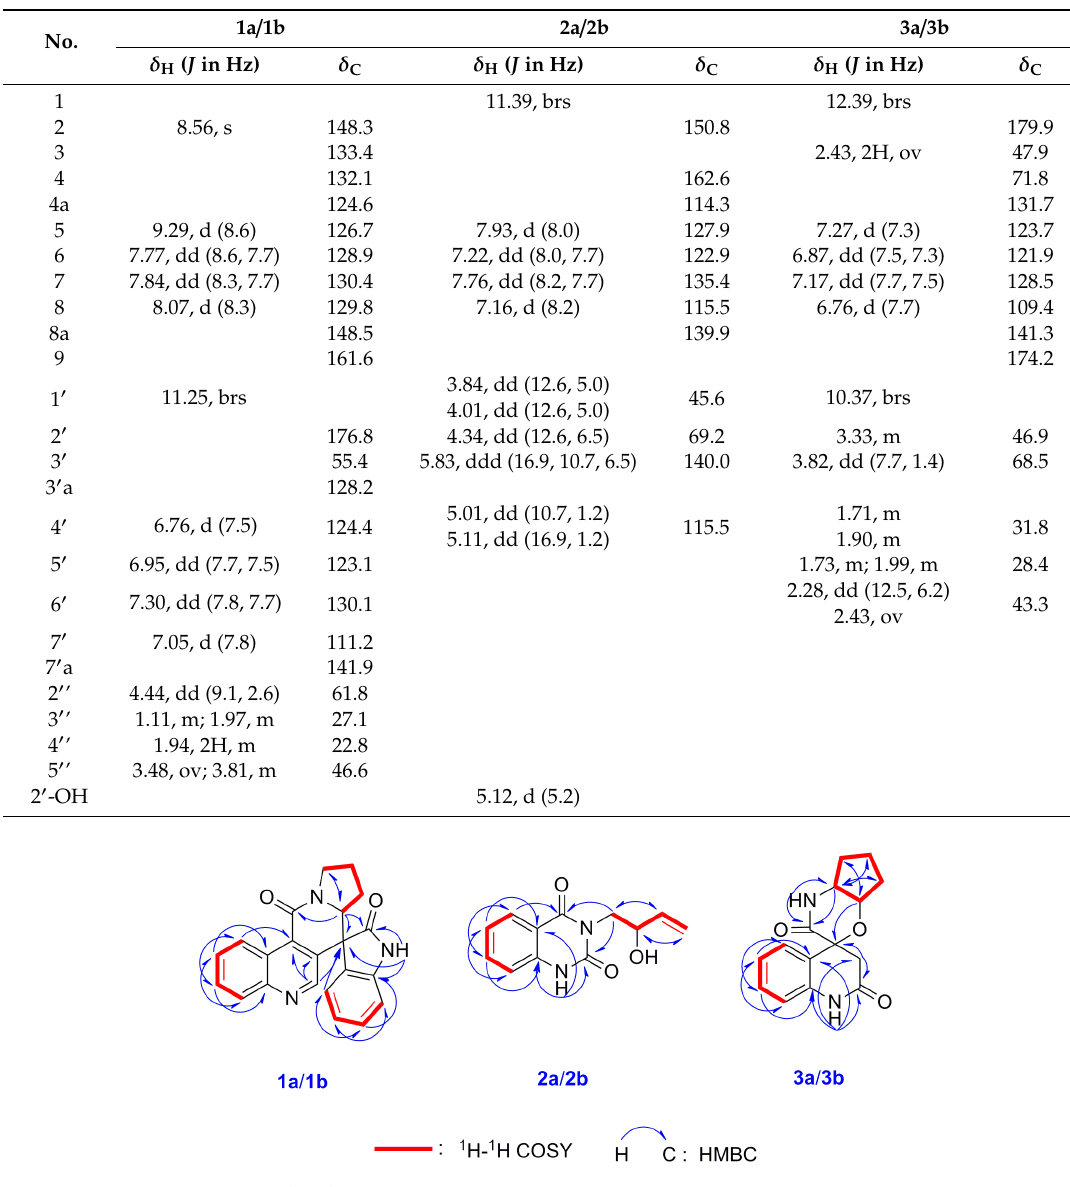
Table 1. 1 H NMR (600 MHz in DMSO- d 6 ) and 13 C NMR data (150 MHz in DMSO- d 6 ) of 1a / 1b – 3a / 3b (ov: overlap signals).